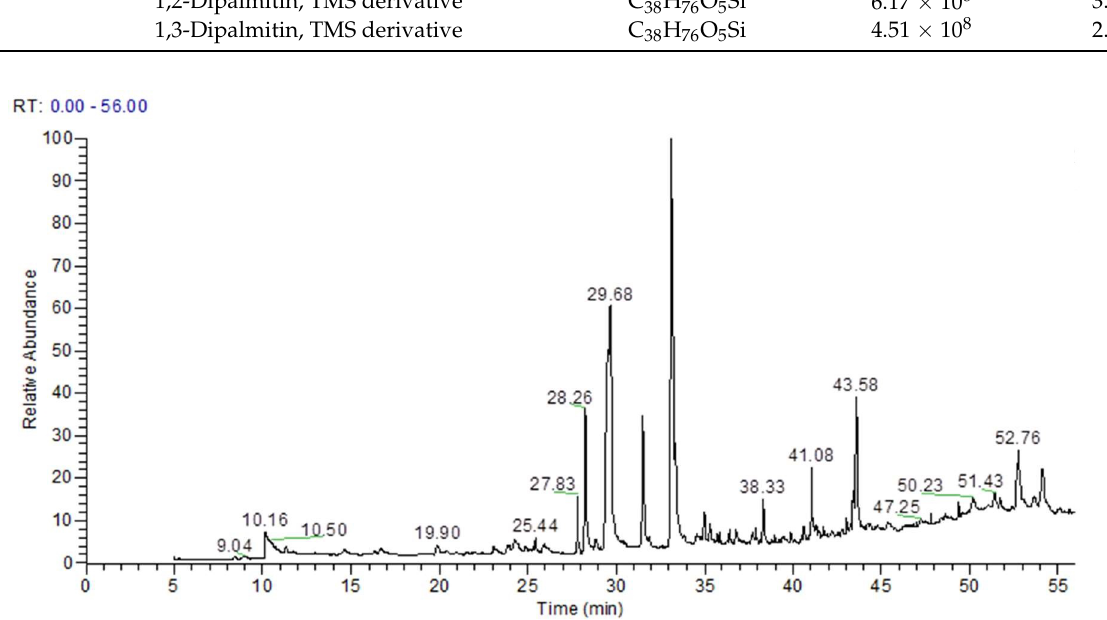
Figure 1. GC-MS chromatogram of ethyl acetate fraction of Anogeissus acuminata leaf